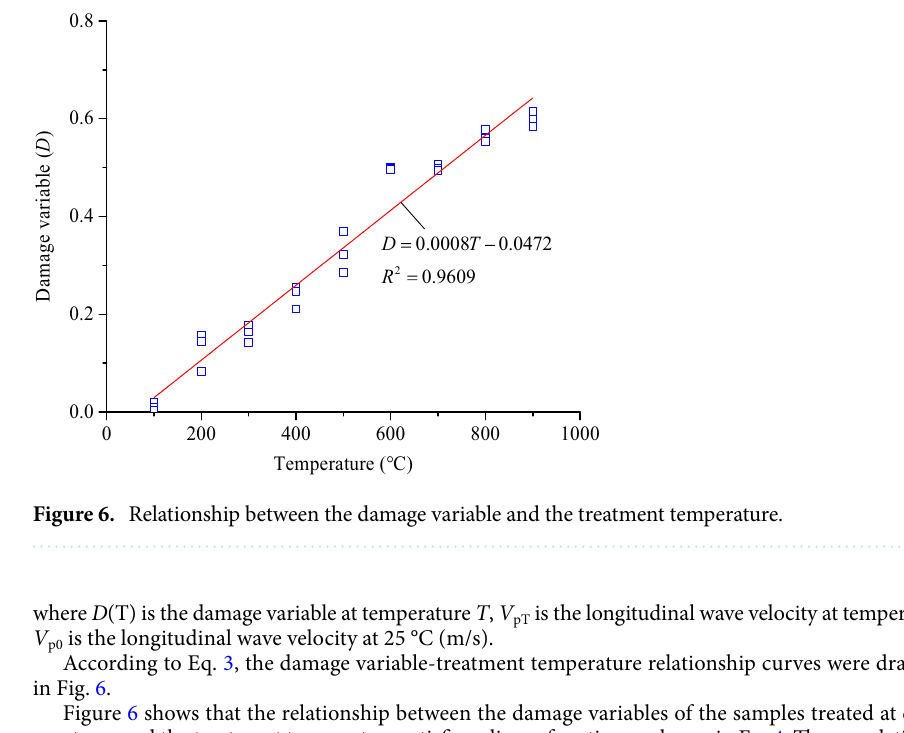
(4) D = 0.0008 T − 0.0472.